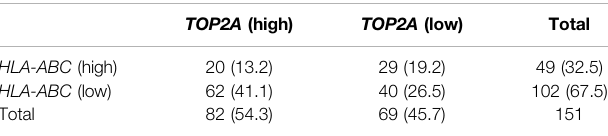
TABLE 3 | Correlation between TOP2A expression and HLA-ABC expression in our own